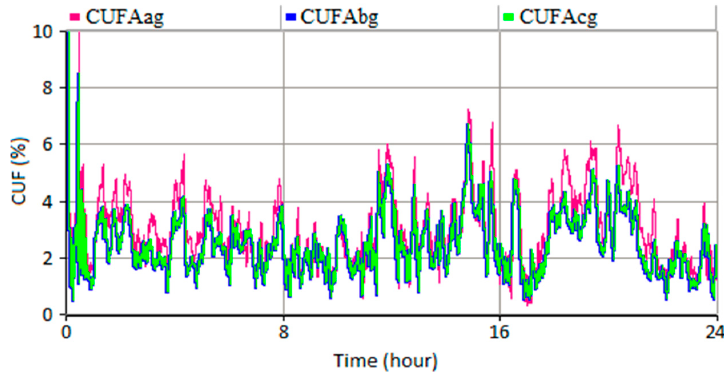
Figure 15. Neutral current changes for MG2 and MG3 in case Ac and Ab.